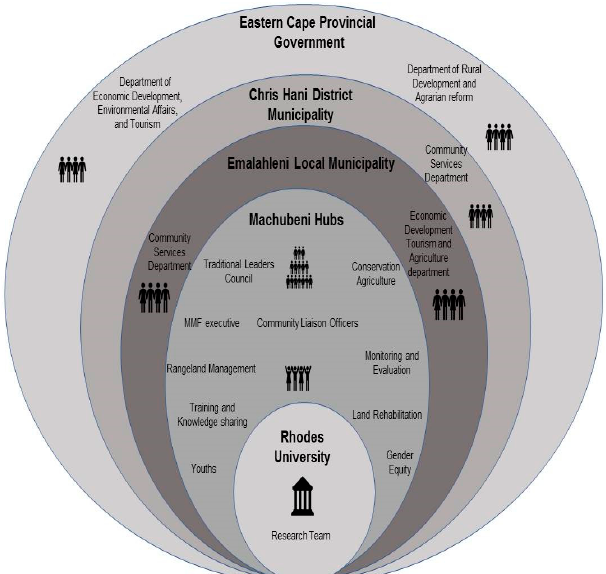
Figure 2. Multi-actor and multi-level onion diagram.